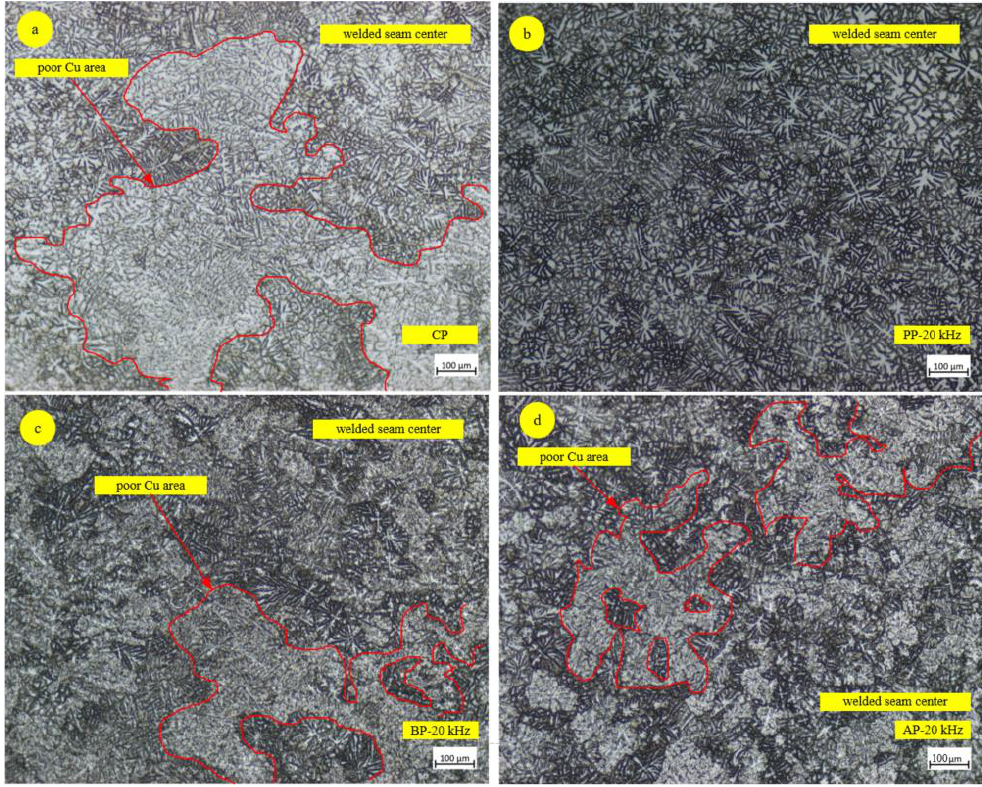
Figure 6. Comparison of regional element segregations under different UFP modes, CP ( a ), PP ( b ), BP ( c ), AP ( d ). BP ( c ), AP ( d